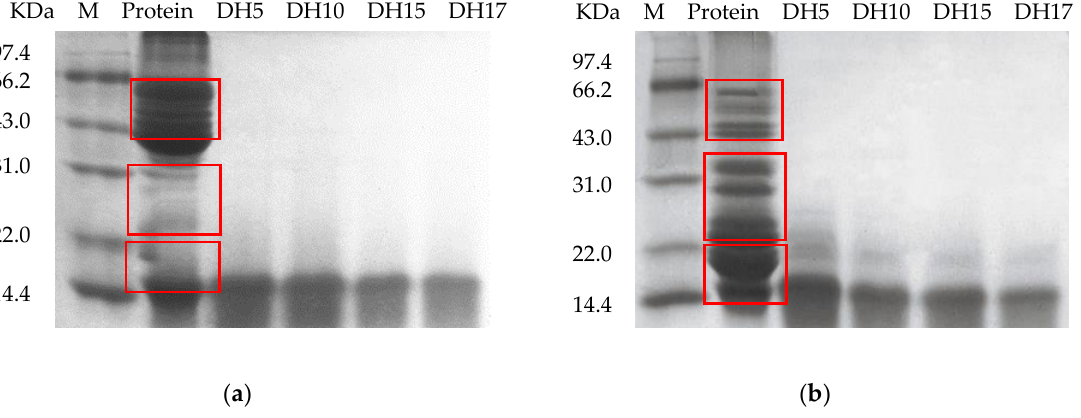
Figure 1. SDS-PAGE profiles of EMO meal protein and hydrolysates under non-reducing ( a ) and reducing ( b ) conditions.